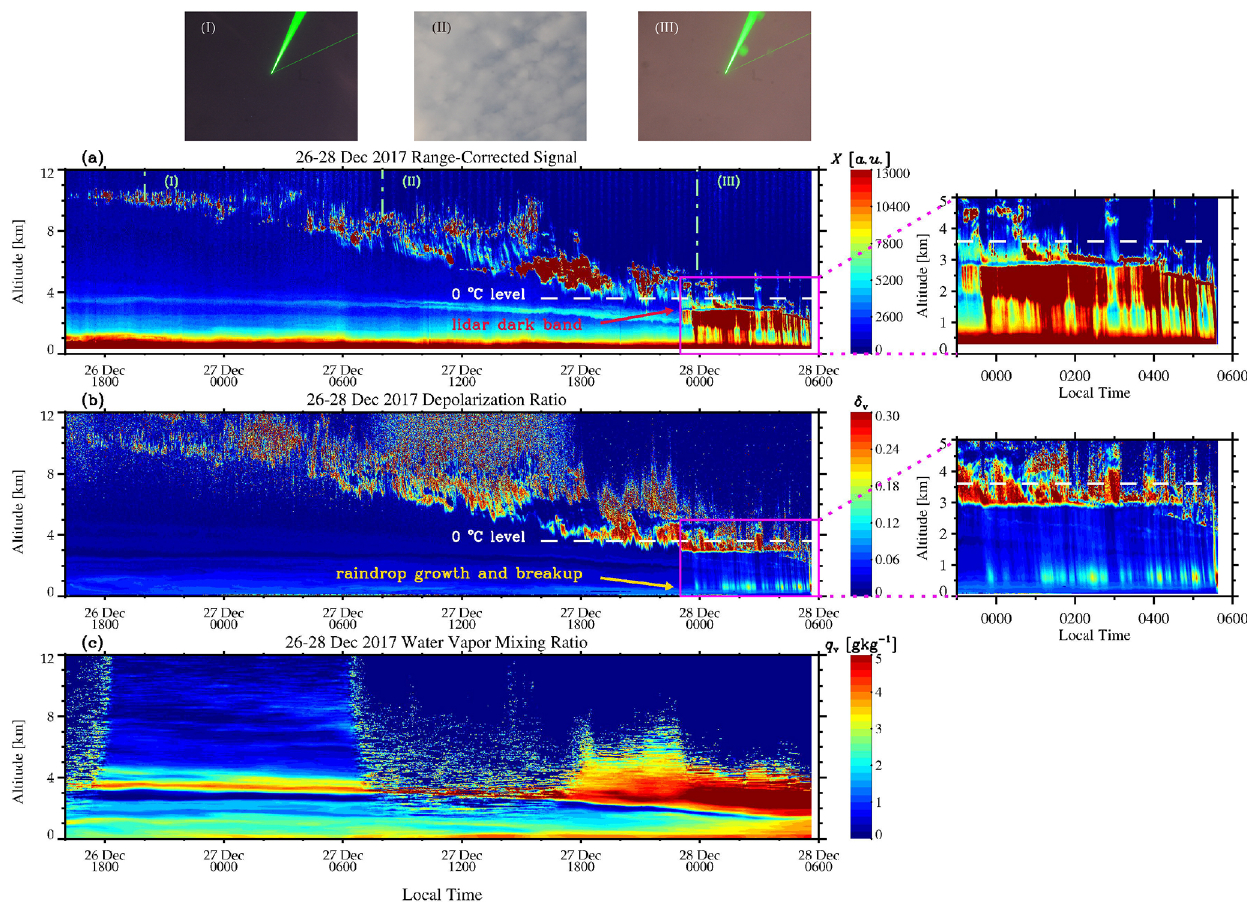
Figure 2. Time–height contour plots (1min and 30m resolution) of the (a) range-corrected signal X , (b) volume depolarization ratio δ v mea- sured by a 355nm polarization lidar and (c) water vapor mixing ratio q v measured by a water vapor Raman lidar on 26–28 December 2017, which exhibited the passage of a warm front and the resulting hours-long light rain. A sliding average of 60min was applied to the Raman lidar data. The precipitation streaks surrounded by magenta lines are zoomed in to show their details. Shown on the top of the figure are the corresponding photographs of the sky taken by a ground-based camera at our lidar site, with the third photograph exhibiting the sky illuminated by a 532nm laser beam during the onset of